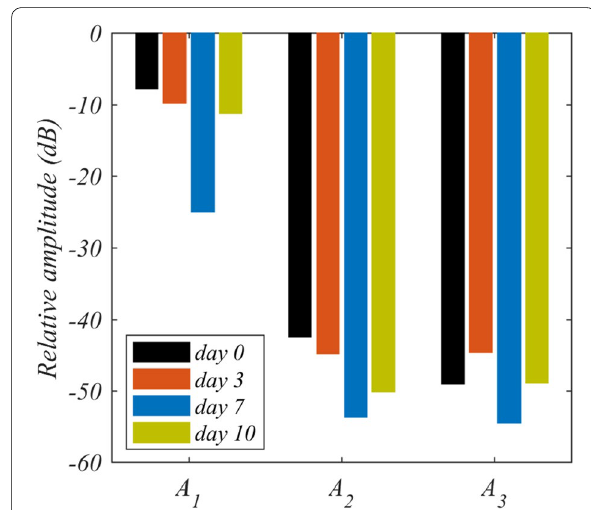
Fig. 11 Relative amplitude evolution of the main components of the frequency spectrum of the received signal for specimen 10 (transducer emitter excited with 180 V). A 1 : relative amplitude of the fundamental frequency ( f 1 30 kHz). A 2 and A 3 : relative amplitudes = of the second and third harmonics, respectively, ( f 2 60 kHz and = f 3 90 =